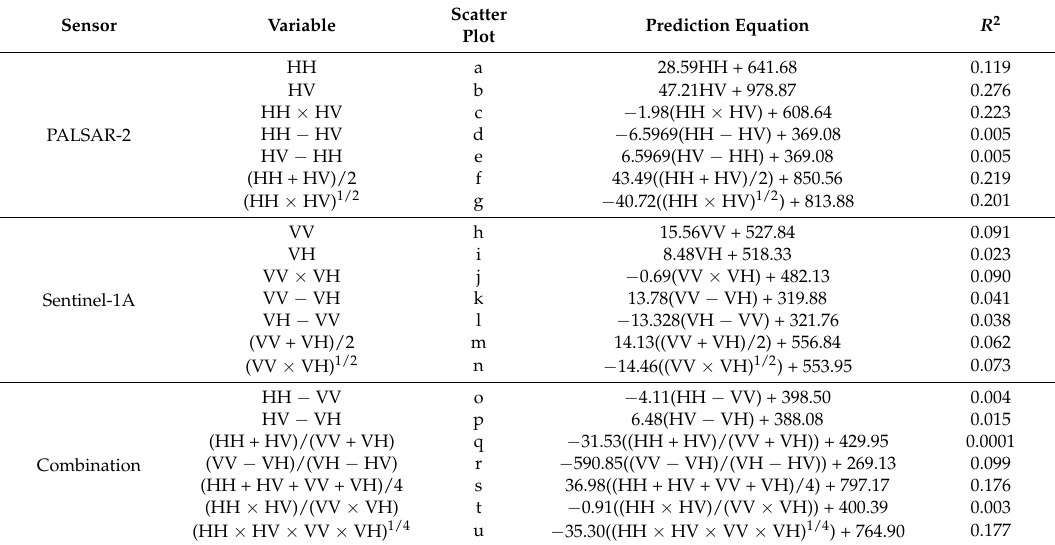
Table 7. Summary of the AGB prediction equations produced from simple linear regression. Sensor Variable